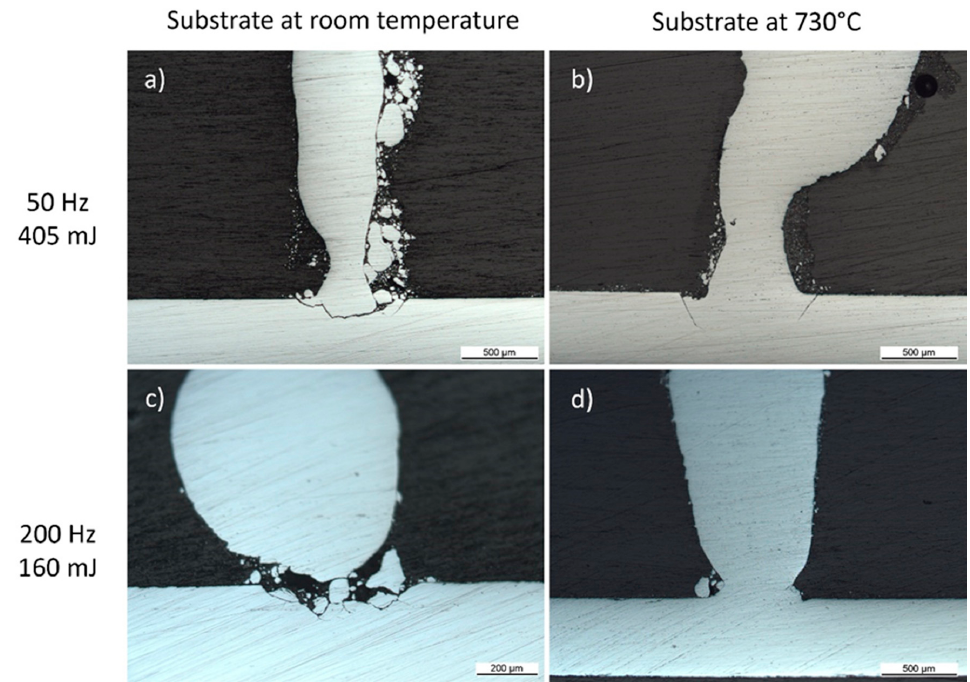
Figure 2. Cross-sections of pillars built on Si <100> wafers using a 1-ms pulse length and a powder feed rate of 15 g/min as a function of different input energies and substrate preheating above the brittle-to-ductile transition of silicon [9]: ( a ) room temperature (RT), 50 Hz, 405 mJ; ( b ) 730 °C, 50 Hz, 405 mJ; ( c ) RT, 200 Hz, 160 mJ; ( d ) 730 °C, 200 Hz, 160 mJ. 405 mJ; ( c ) RT, 200 Hz, 160 mJ; ( d ) 730 ◦ C, 200 Hz, 160